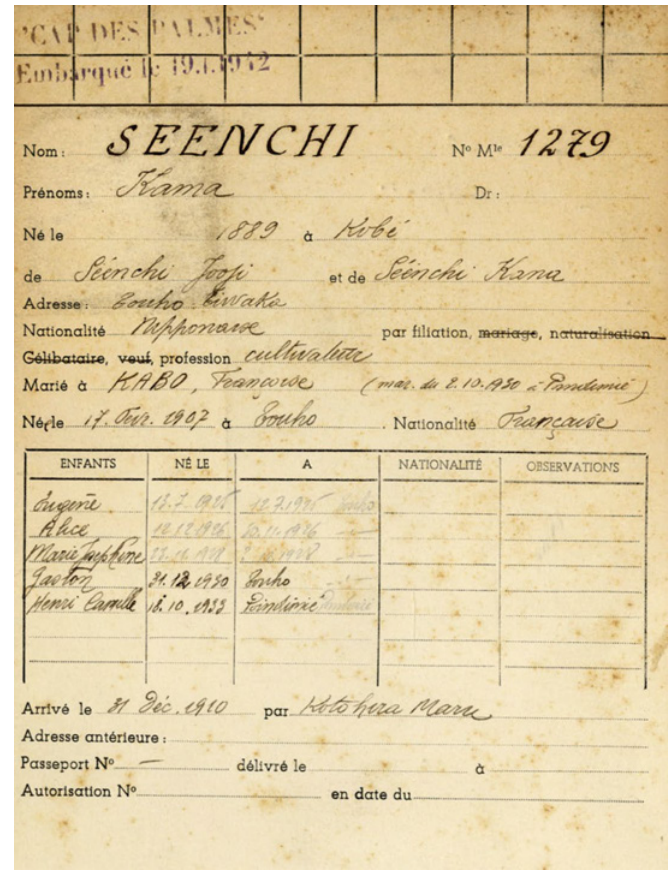
Figure 1 Identity card of Kama Seenchi, deported in January 1942. The column nationalité that should indicate the nationalities of his five children strikingly remains empty. The card labels Seenchi as the husband of Françoise Kabo, a Kanak of the Kokengone tribe near Poindimié, New Caledonia (ANC 34W 39) © Archives de la Nouvelle-Calédonie, used with